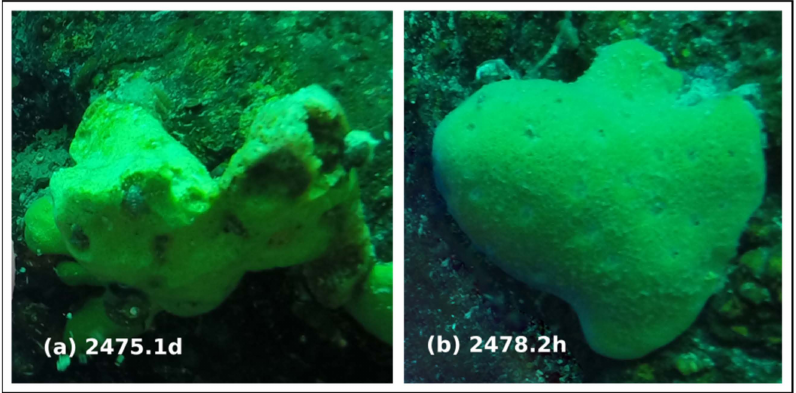
Figure 1. The sponges Baikalospongia bacillifera , ( a ) diseased and ( b ) healthy individuals, used in our study of DNA viral